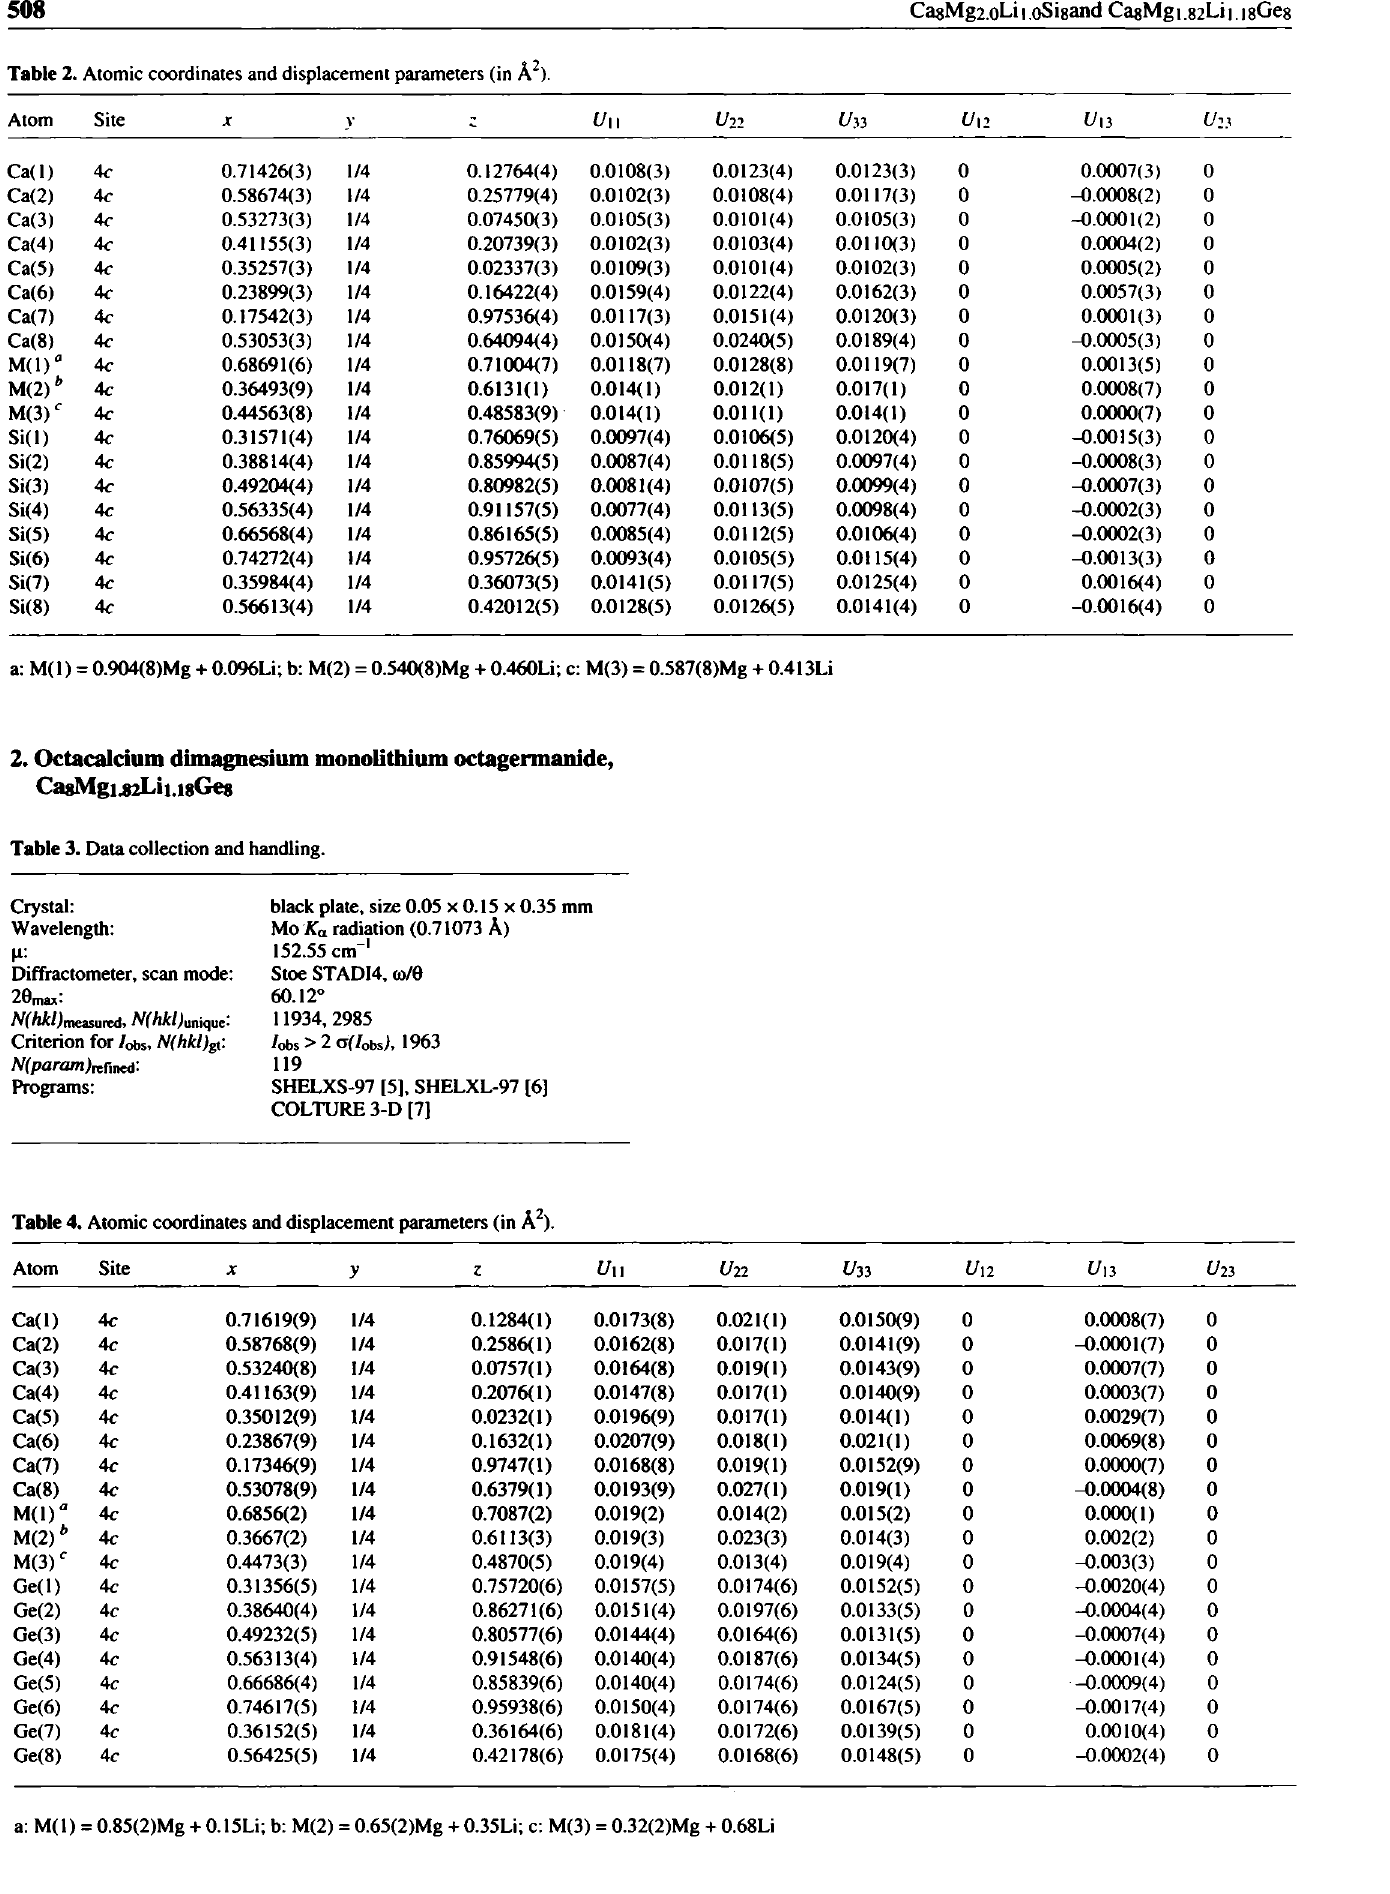
Table 4. Atomic coordinates and displacement parameters (in A 2